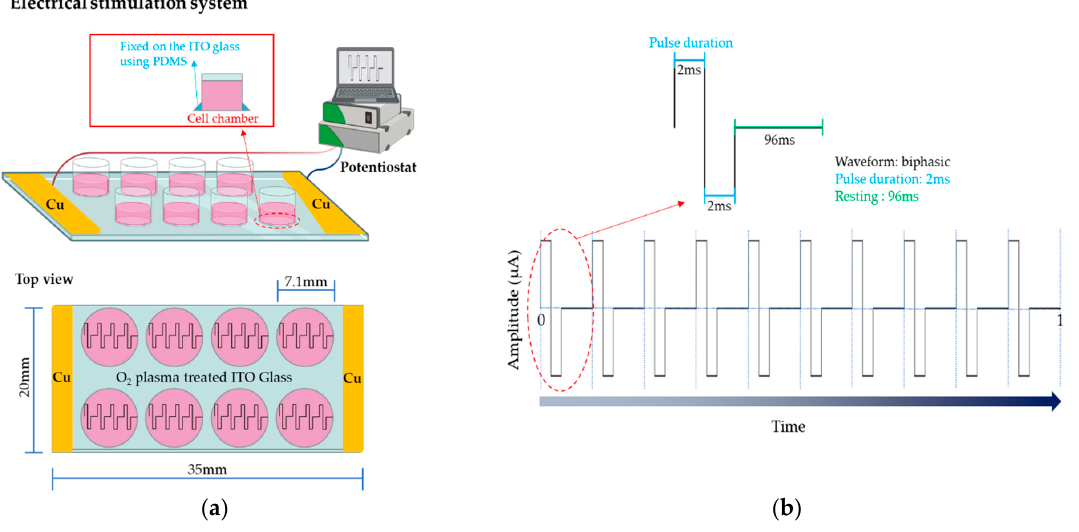
Figure 6. Schematic diagram of the electrical stimulation setup. ( a ) PDMS was used to fix the chambers onto the ITO glass. The yellow bars represent the Cu plate electrodes. ( b ) The electrical stimuli applied to adipose-derived mesenchymal stem cells in this study.